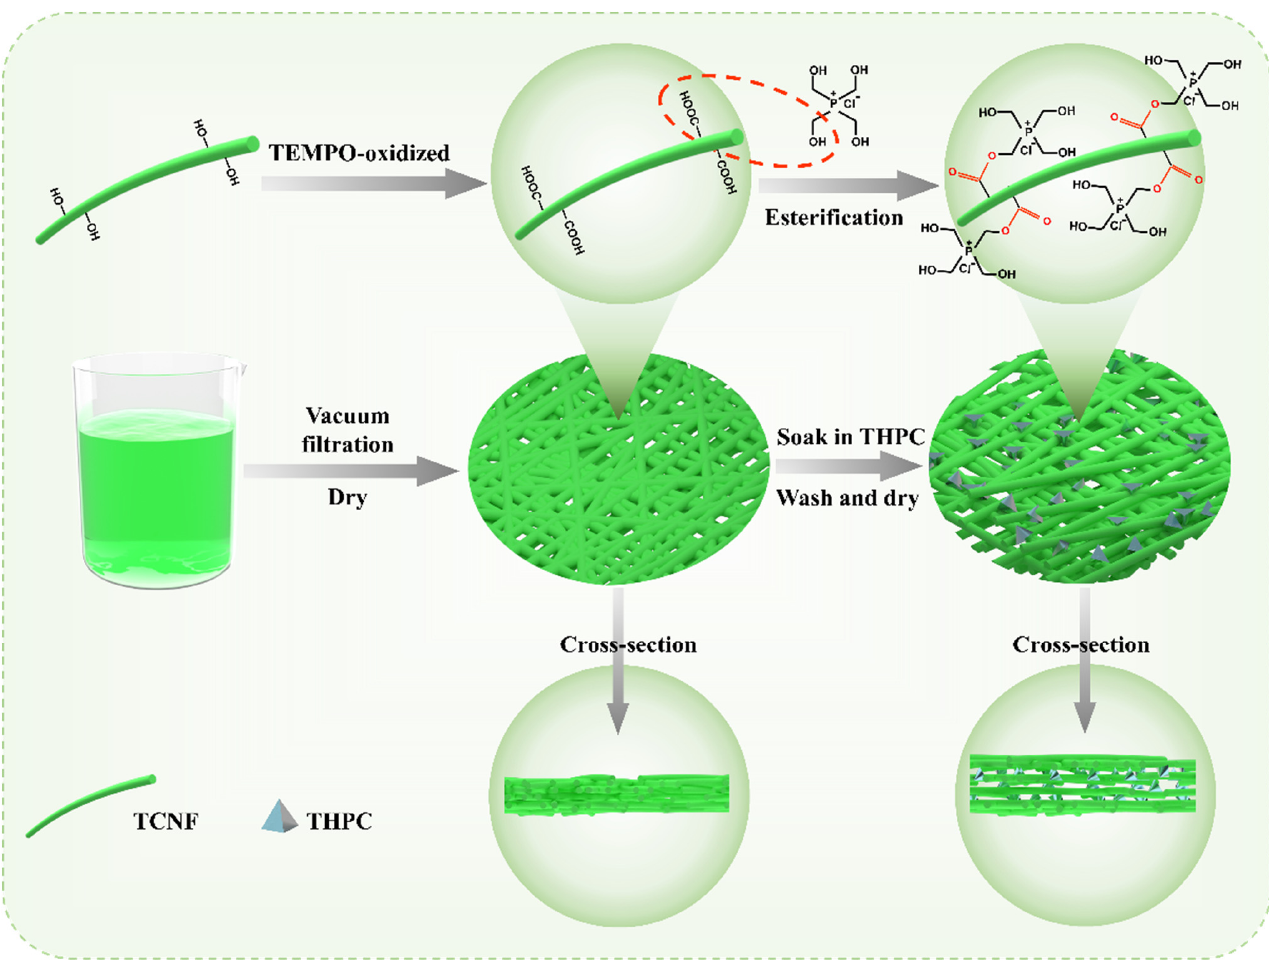
Figure 1. Schematic illustration for the fabrication process of THPC@TCNF membrane.